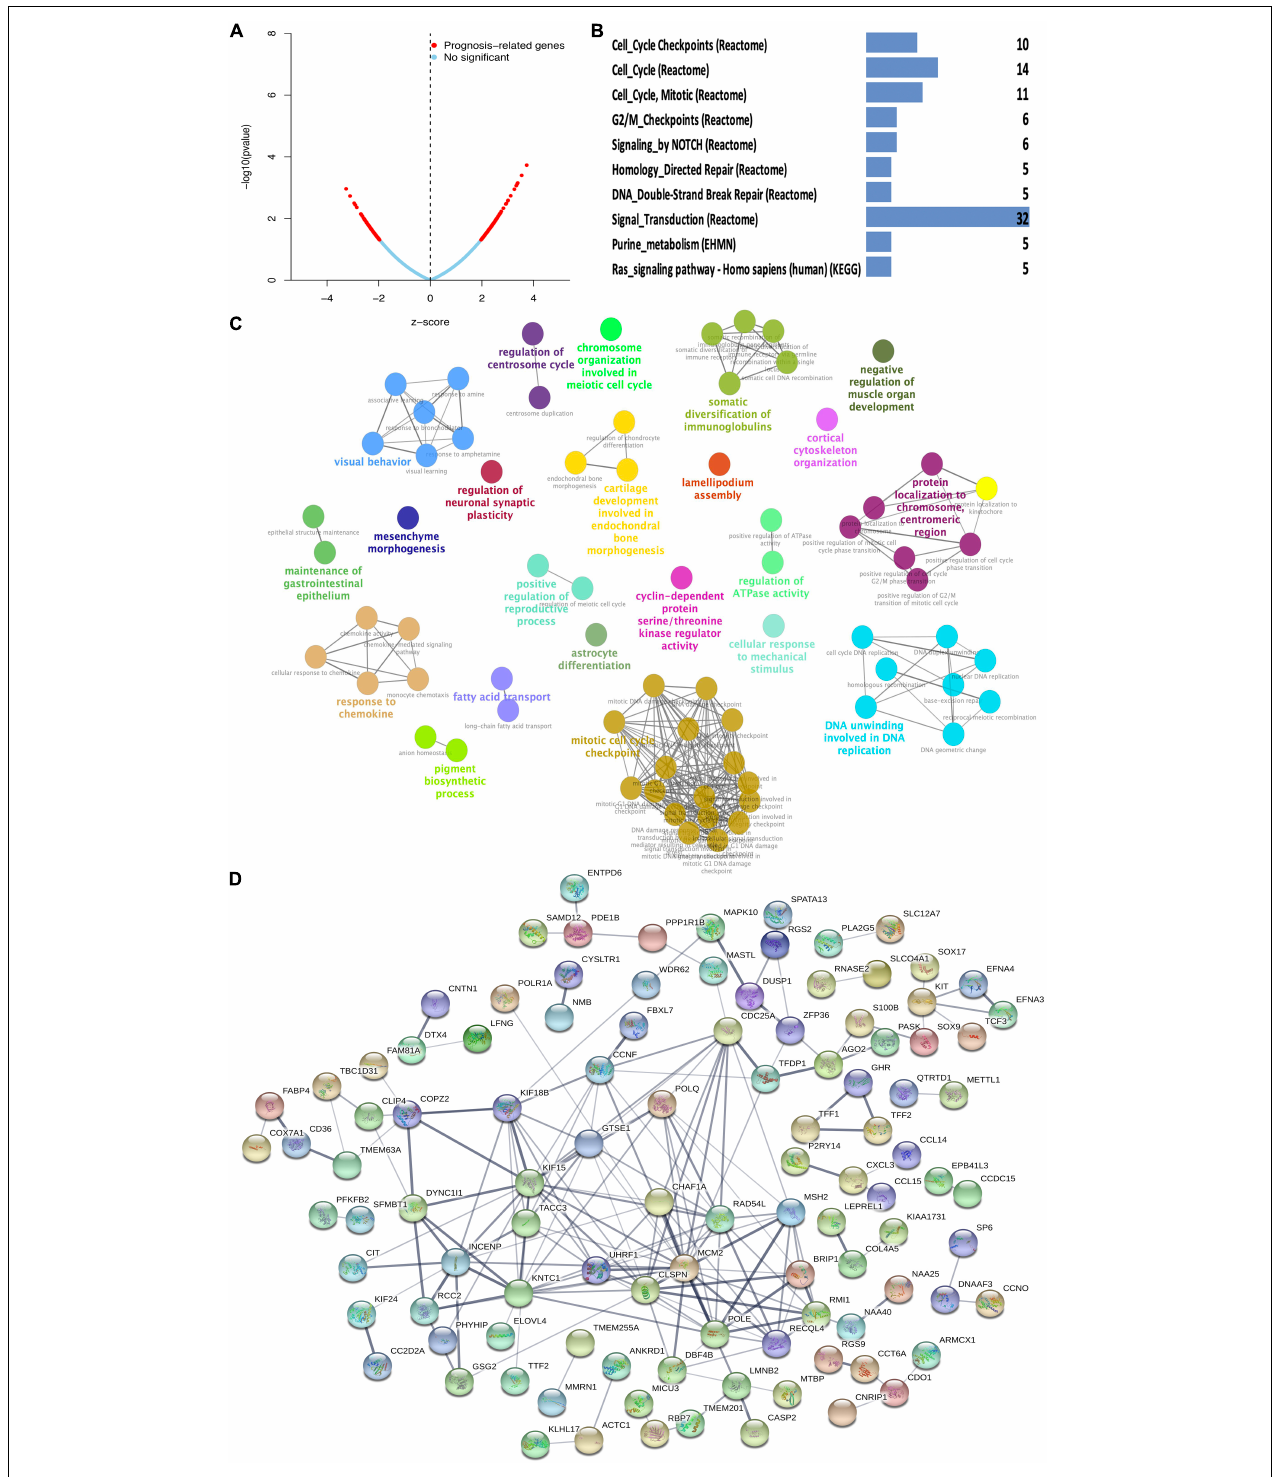
FIGURE 3 | Function enrichment analysis of survival-related DEGs in STAD. (A) Prognosis-related genes by Cox regression in blue and brown co-expression modules. (B) KEGG pathway of survival-related DEGs in blue and brown co-expression modules. (C) GO-BP analysis of survival-related DEGs in blue and brown co-expression modules. A lower P -value and more significant enrichment were shown with greater node size. The same color indicated the same function group. Among the groups, we chose a representative of the most significant term and lag highlighted. (D) PPI network of survival-related DEGs in blue and brown co-expression